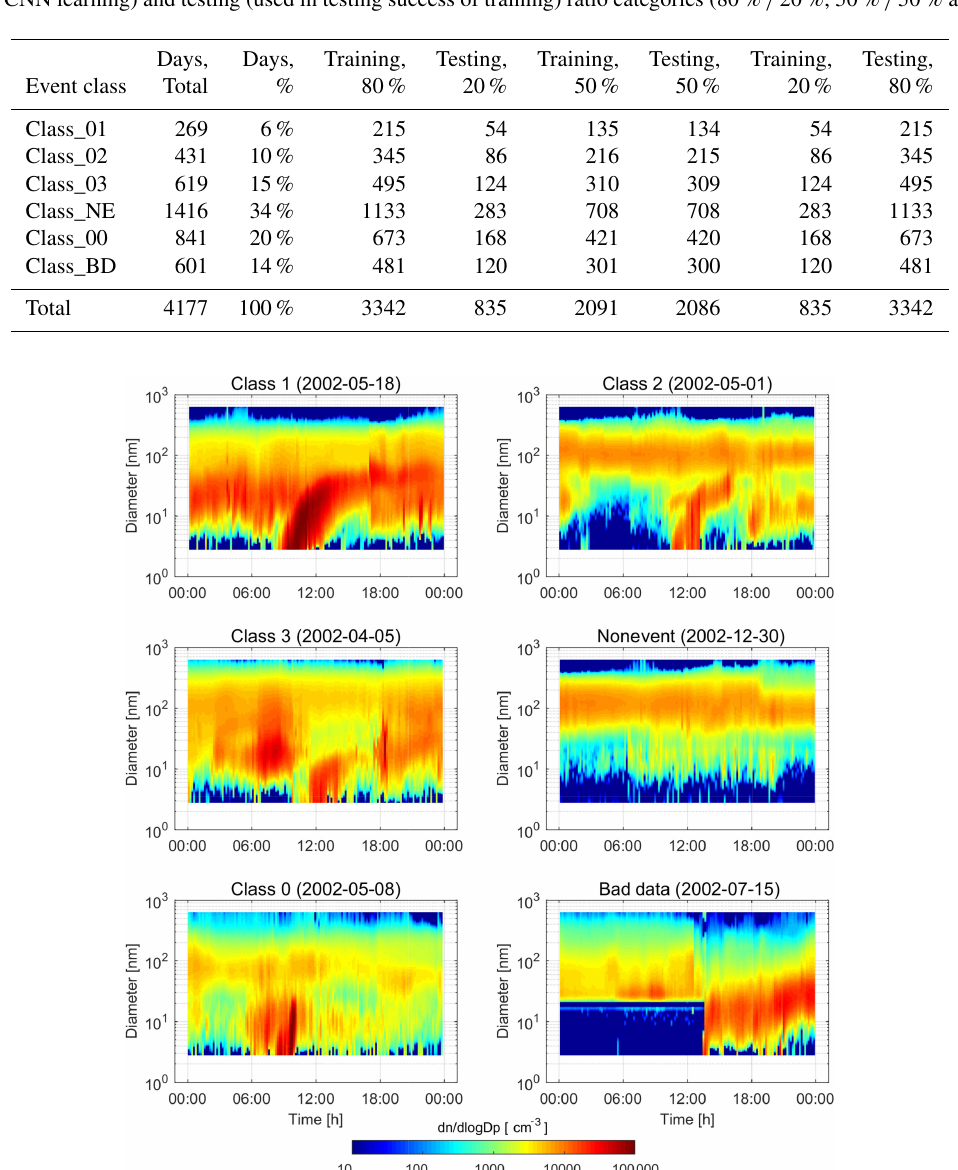
Figure 1. Examples of particle size distributions (time in x axis, particle diameter in y axis and particle concentration presented by different colors) for different NPF event classes. Name of event class is indicated in plot title and date of measurement in